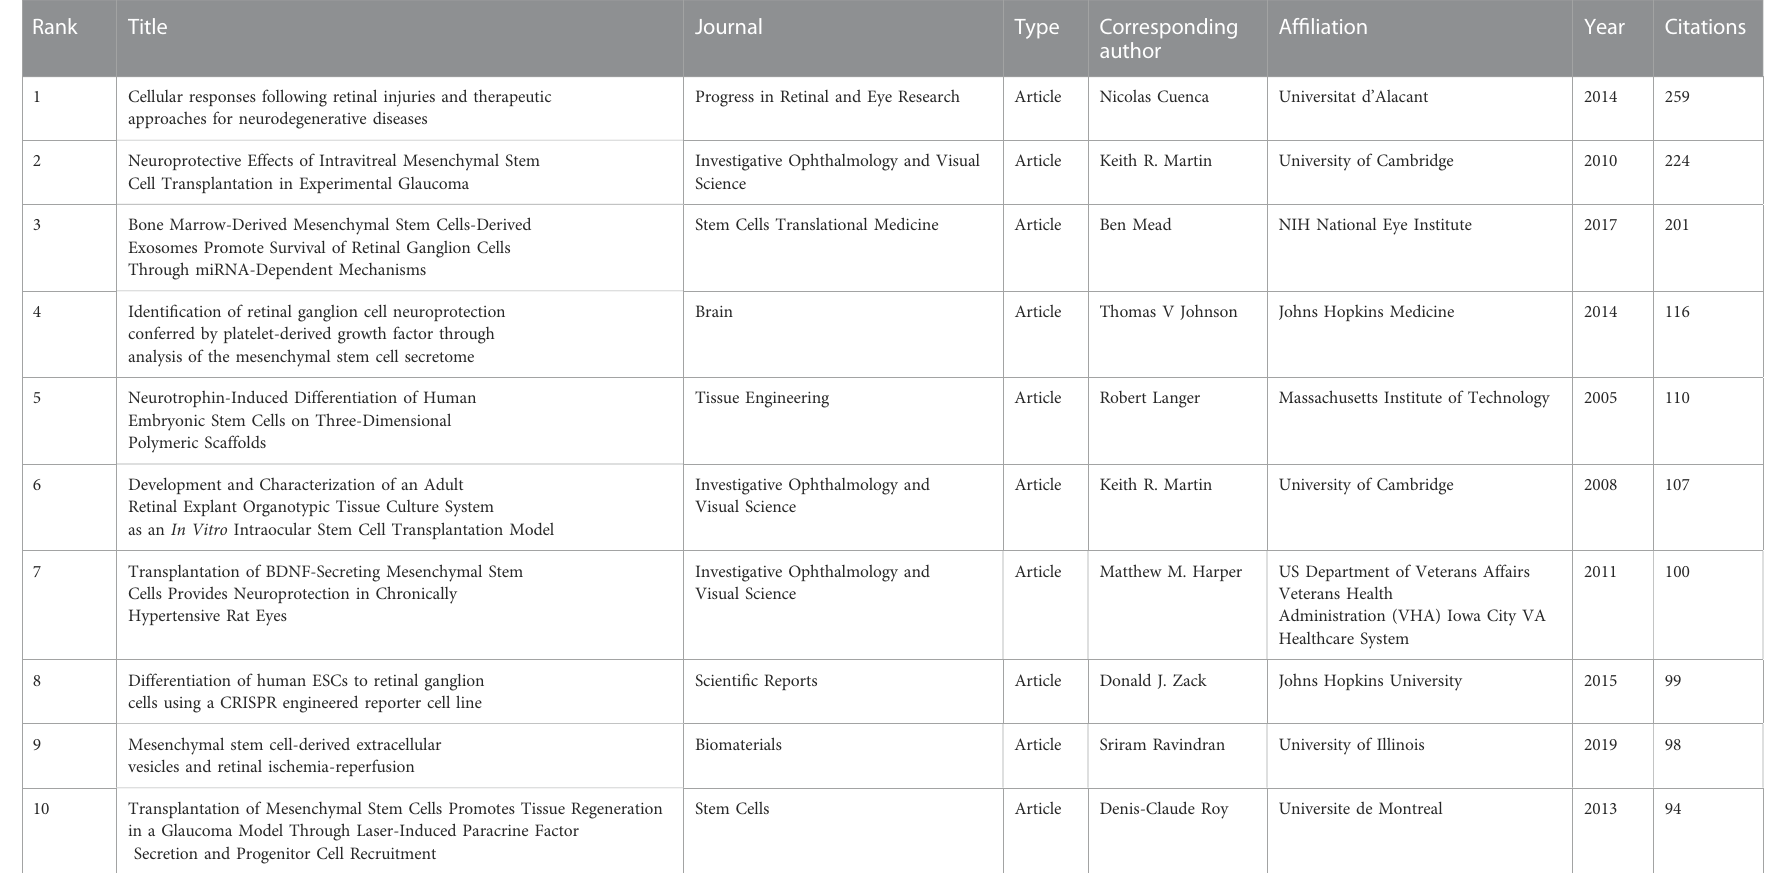
TABLE 3 Top 10 most cited papers related to the application of stem cells in glaucoma.